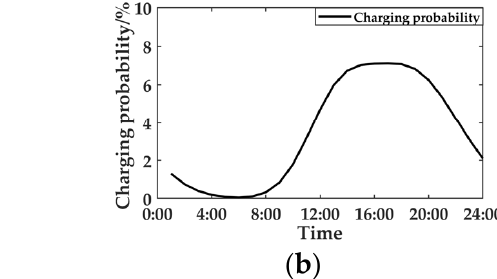
Figure 8. Private vehicles and EV ownership in residential areas.